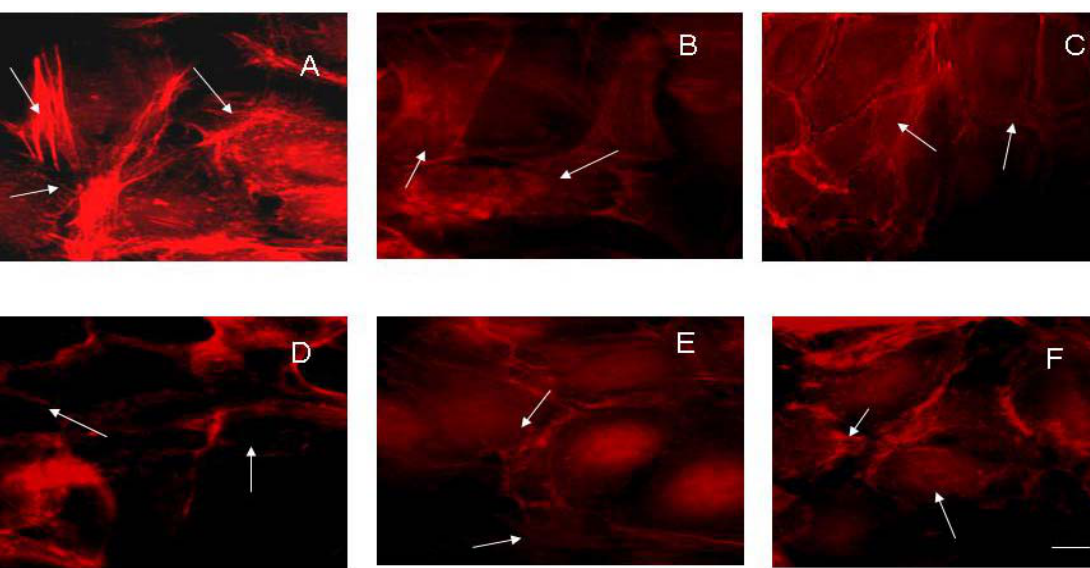
Figure 3. Fluorescent imaging of actin (BODIPY 558/568 phalloidin-labelled) after treatment of HaCaT cells with electrical pulses and/or 20 μ g·mL − 1 rifampicin. ( A ) Untreated control HaCaT cells; ( B ) HaCaT cells, treated with 20 μ g·mL − 1 rifampicin alone; ( C ) HaCaT cells 24 h after electroporation with 1,000 V, only. ( D – F ) HaCaT cells treated with 20 μ g·mL − 1 rifampicin plus 200 V, 500 V, 1,000 V, respectively.